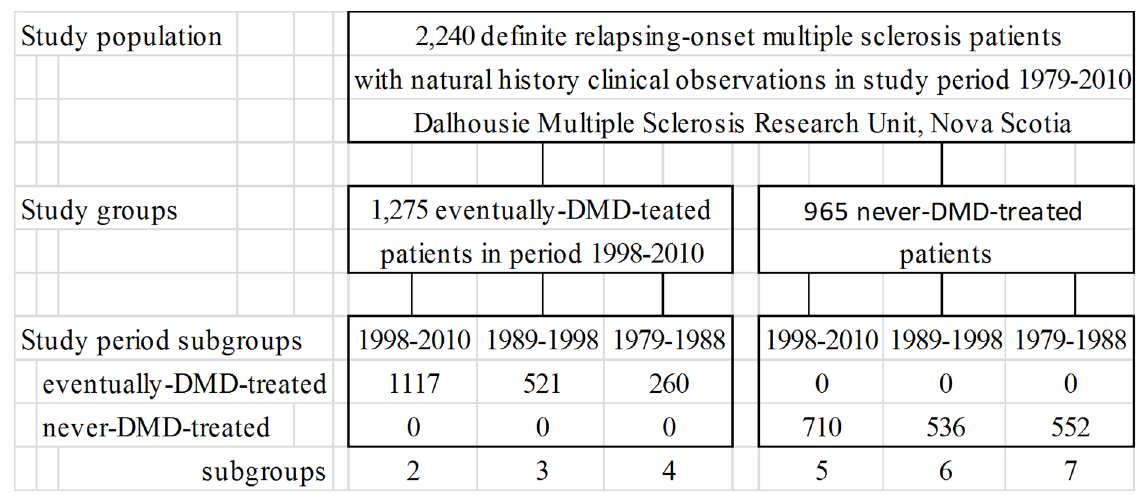
Figure 1. Natural history study population, study groups and study periods. Footnote: DMD=disease-modifying-drug(s). EDSS=Expanded disability Status Scale. The study population includes 2,240 definite relapsing-onset (R-MS) patients who attended DMSRU clinics in study period 1979–31 December2010 while receiving regular care, but not DMDs. This natural history population includes 29 eventually-DMD-treated R-MS patients who were later reclassified as primary progressive. 1,275 R-MS patients were eventually-treated with DMDs under Nova Scotia’s Special Therapies Program in period 1 Aug1998 to 31 Dec2010. 965 R-MS patients were never-treated with DMDs. Unique patients may be included in more than one study groups, depending on when their observations were collected. For example, a patient with at least one EDSS observation in study period 1979–1988 may or may not have observations in period 1989–1998 or 1998–2010.